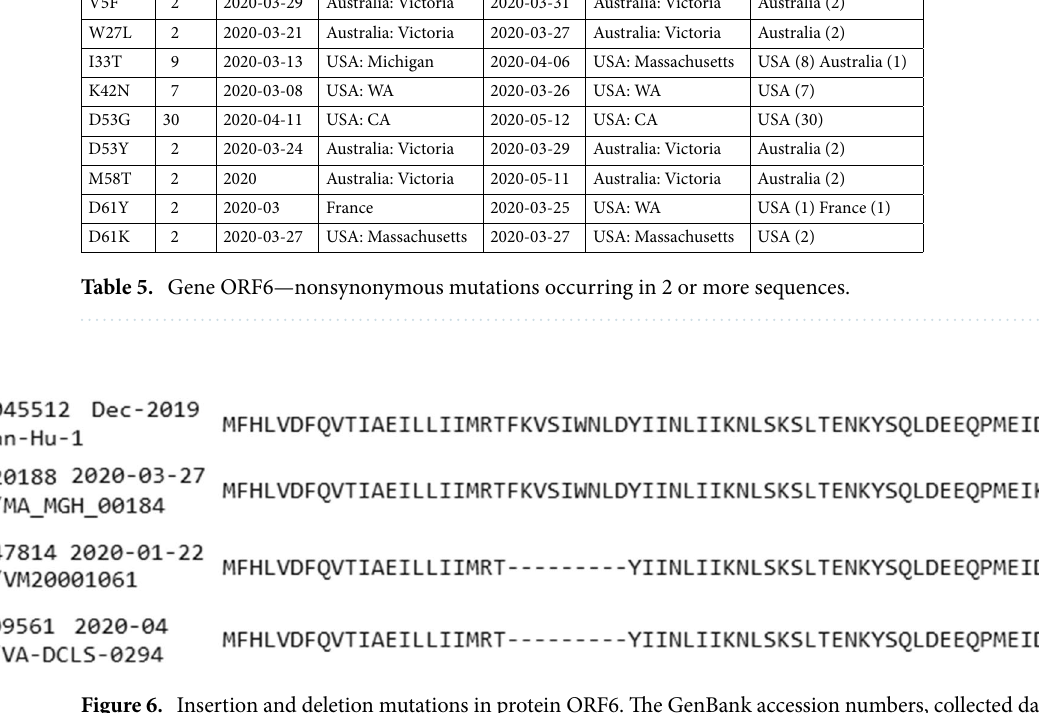
Figure 6. Insertion and deletion mutations in protein ORF6. The GenBank accession numbers, collected dates and isolate names are presented on the left. One synonymous mutation D61K and two insertions − 62R and − 63T at the end of isolate USA/MA_MGH_00184/2020 (MT520188) is interesting while there is a high chance that HKG/VM20001061/2020 has spread to USA/VA-DCLS-0294/2020. Mu